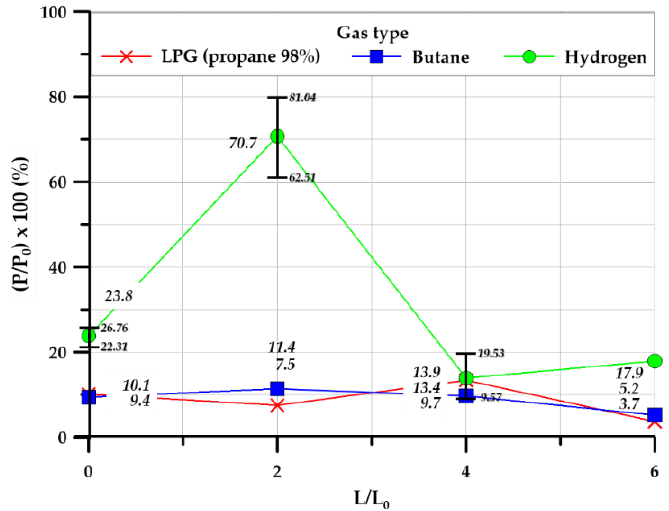
Figure 18. Pressure ratio in the square-type chamber .